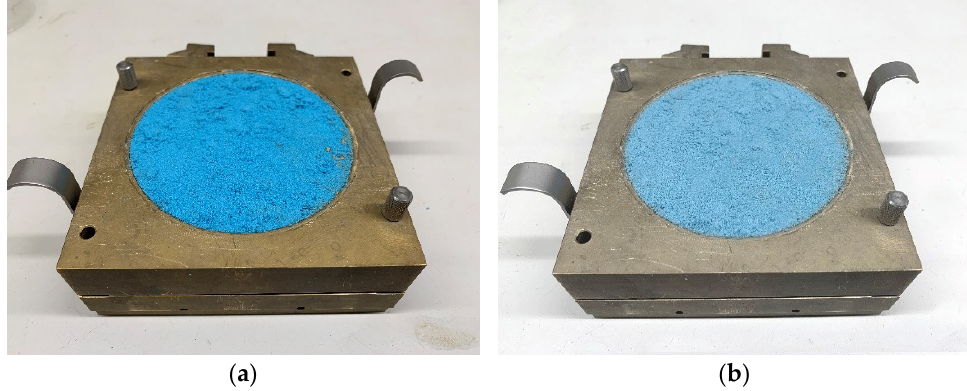
Figure 11. Sample of kinetic sand in the container of direct shear apparatus. ( a ) Original sample before testing; ( b ) Boiled sample before testing.